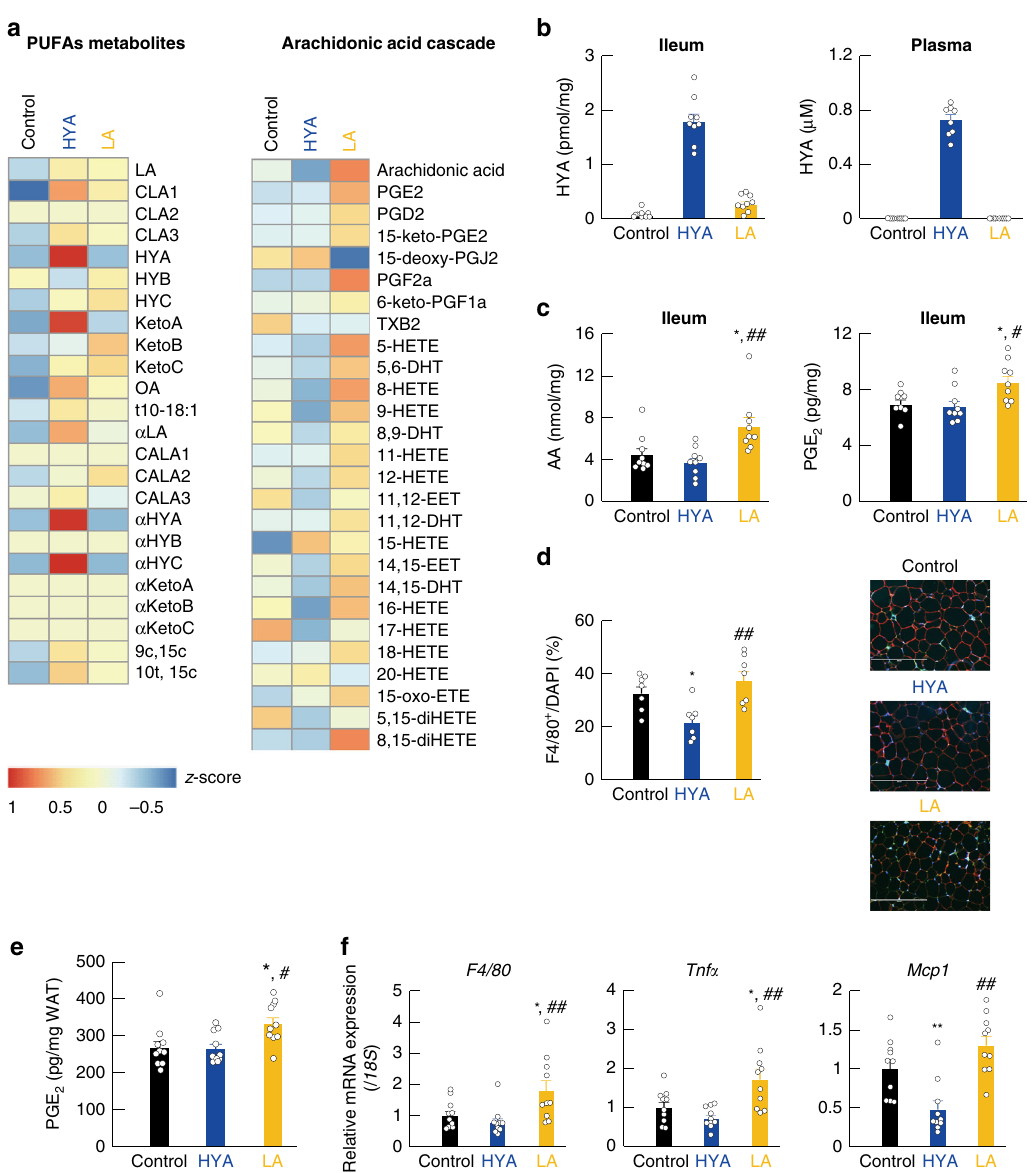
Fig. 4 Gut microbial PUFA metabolites and adipose in fl ammatory response. a Heat map of FA pro fi les in the ileum ( n = 4 per group). b HYA was detected in the ileum (left) and plasma (right) ( n = 9 per group in the ileum; n = 9, 8, and 9 per group in the plasma). c Arachidonic acid (left) and PGE2 (right) were quanti fi ed in the ileum ( n = 9 per group for arachidonic acid; n = 8, 9, and 9 per group for PGE2). d WAT sections were labeled by F4/80 (green), caveolin- 1 (red), and DAPI (blue), and F4/80-positive cells were measured ( n = 7 per group). Scale bar, 400 μ m. e Levels of adipose PGE2 ( n = 10 per group). f mRNA expression of F4/80, Tnf α , and Mcp1 in the WAT of HFD-induced obese mice ( n = 10 per group). ** P < 0.01; * P < 0.05 vs. control (Tukey –